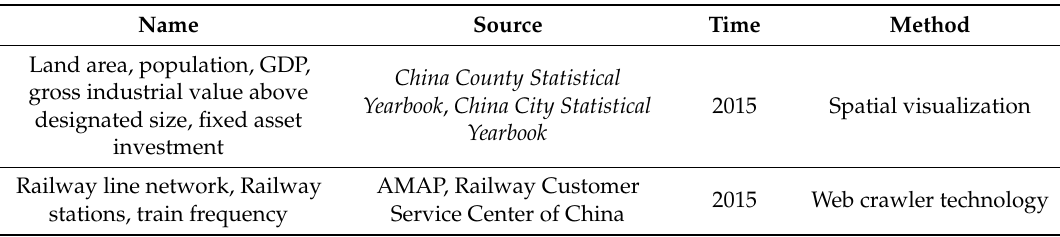
Table 1. Data sources for the railway network distribution of China in